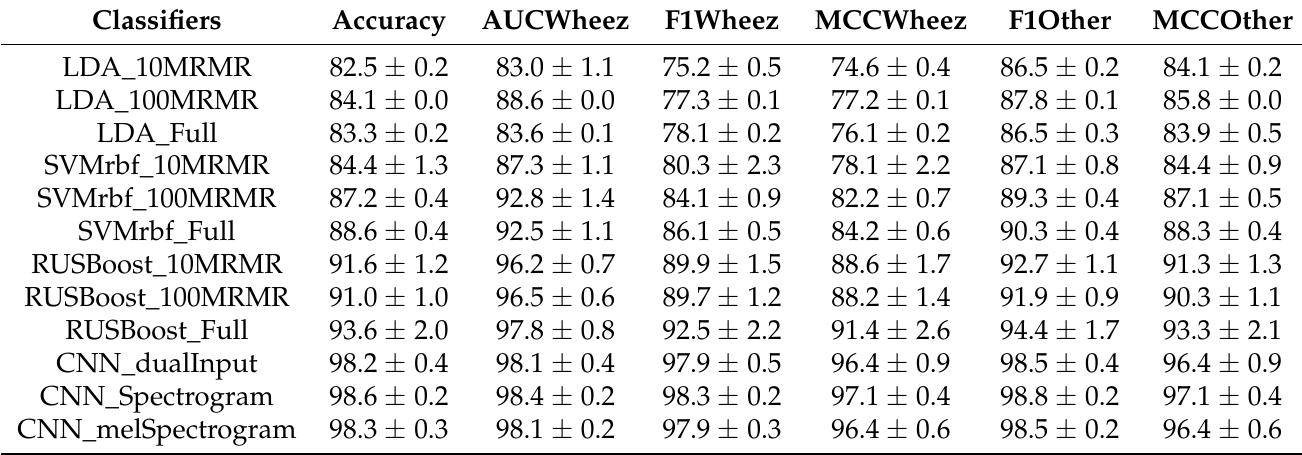
Table 10. Performance results obtained with 2 classes (wheeze vs. other)—training: fixed duration; testing: fixed